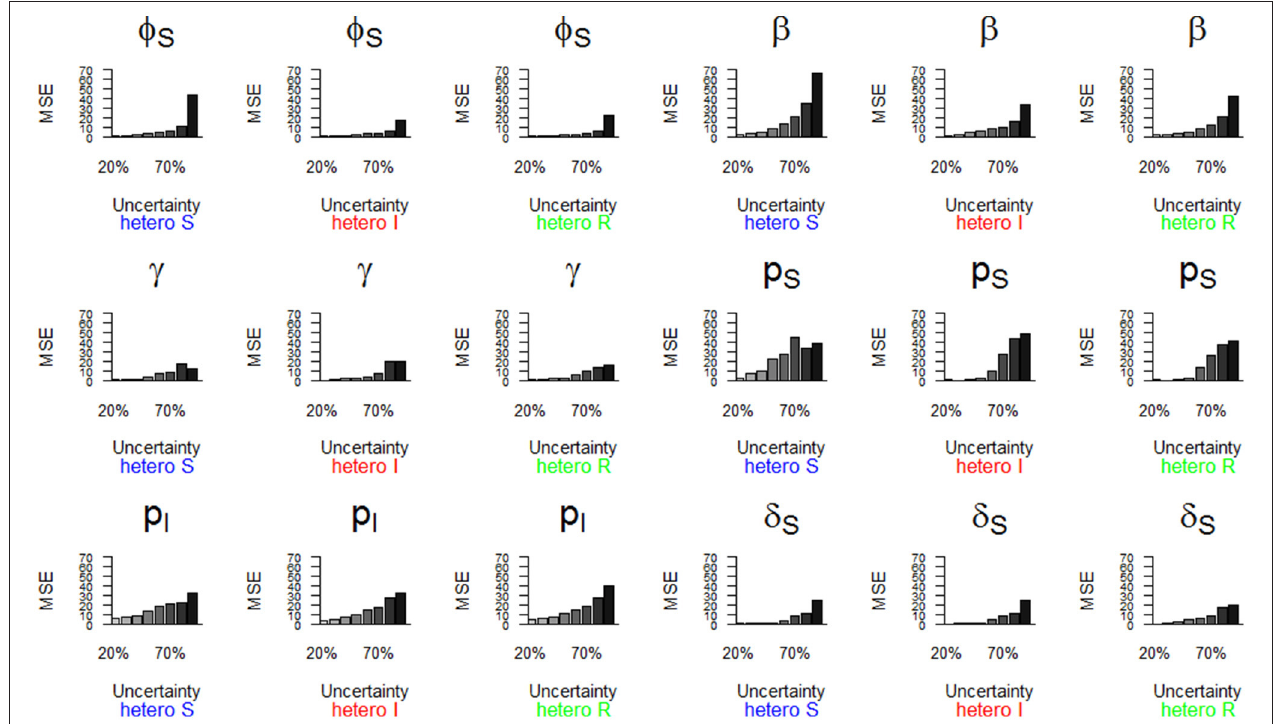
FIGURE 6 | Parameter estimates with a precision (MSE) greater than 15 as a function of a heterogeneous increase in state uncertainty. The increasing state uncertainty corresponds to a decreasing probability of assigning an infection state. We used the following notations for the parameters: φ S for the survival probability of individuals in the S state, β for the infection probability, γ for the recovery probability , p S and p I for the detection probability of individuals in S and I states, and δ S for the assignment probability of individuals in the S state. Scenarios of assignment heterogeneity were reducing by 50% the assignment probability of the S state compared to the assignment probability of the I and R states (“hetero S” (blue)), reducing by 50% the assignment probability of the I state compared to the S and R states (“hetero I” (red)) and reducing by 50% the assignment probability of the R state compared to S and I states (“hetero R”